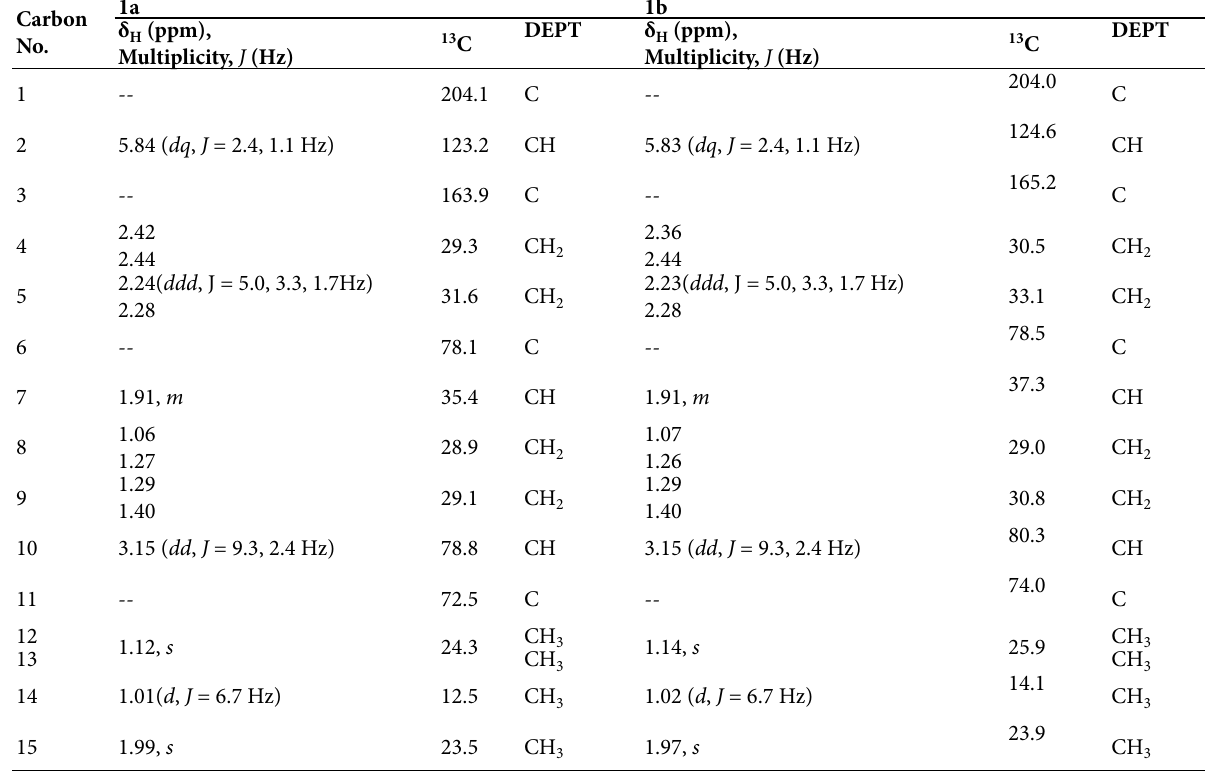
Table 1. 13 C and 1 H NMR data for compound 1a and 1 b (CD 3 OD at 125 and 400 MHz, respectively).